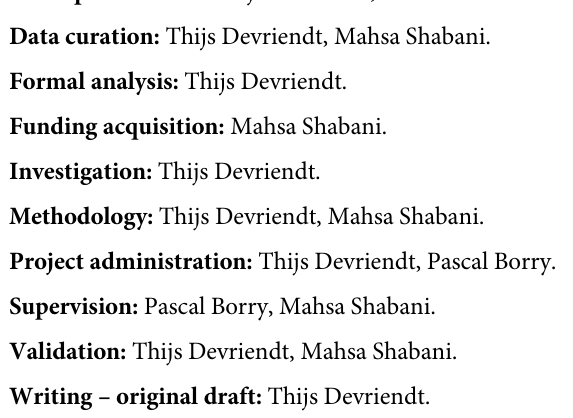
S1 Table. Summary table of answers to questions on experiences with data